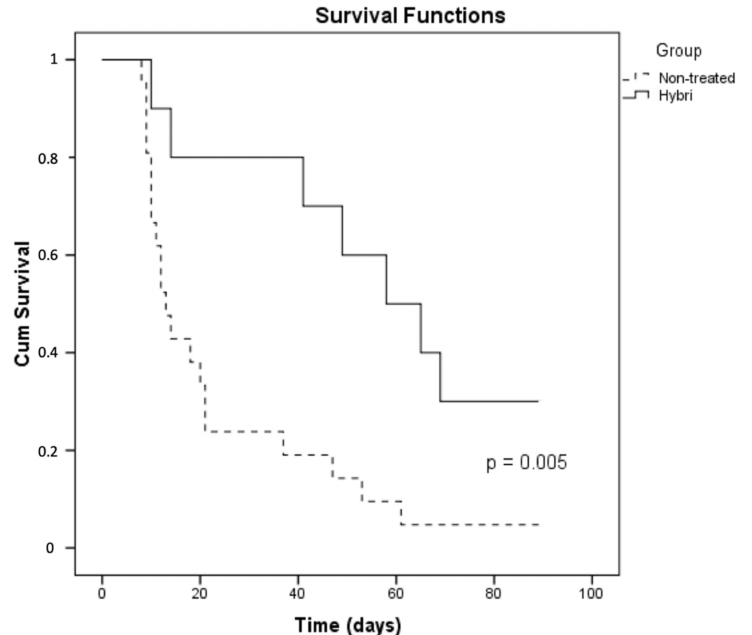
Figure 7. Survival differences with the Kaplan Meier analysis of the two studied groups in the rat allogeneic transplant model.